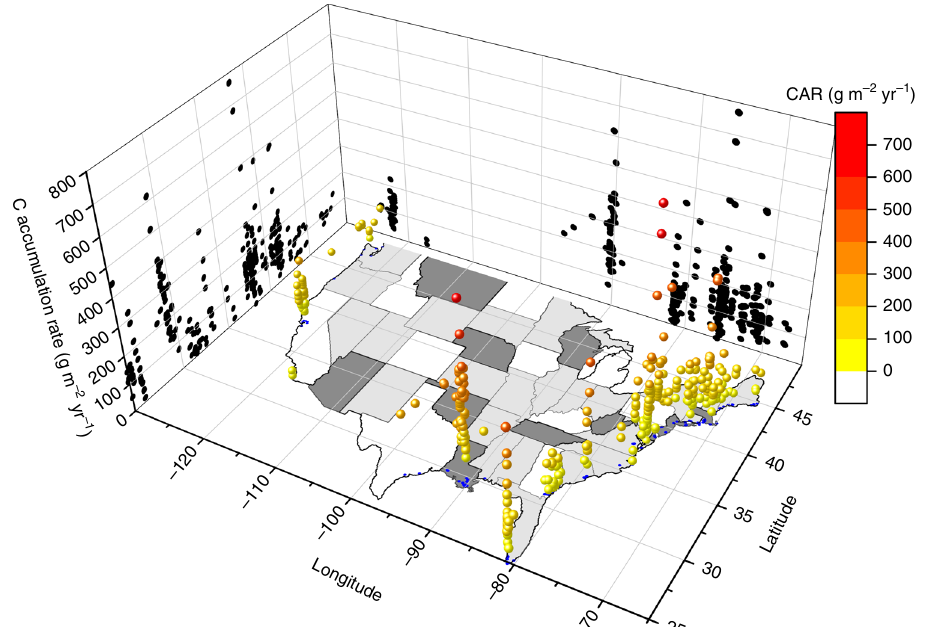
Fig. 2 The 3D scatter plot of all soil C accumulation rate points across the tidal wetlands in the conterminous United States. The black dots on side walls are the projection of each data point to Latitude and Longitude,